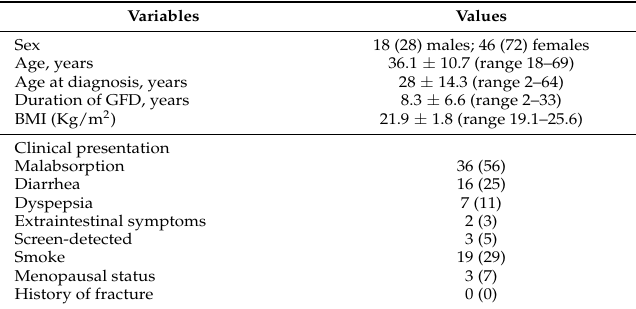
Table 1. Characteristics of the 64 patients with celiac disease on a gluten-free diet.